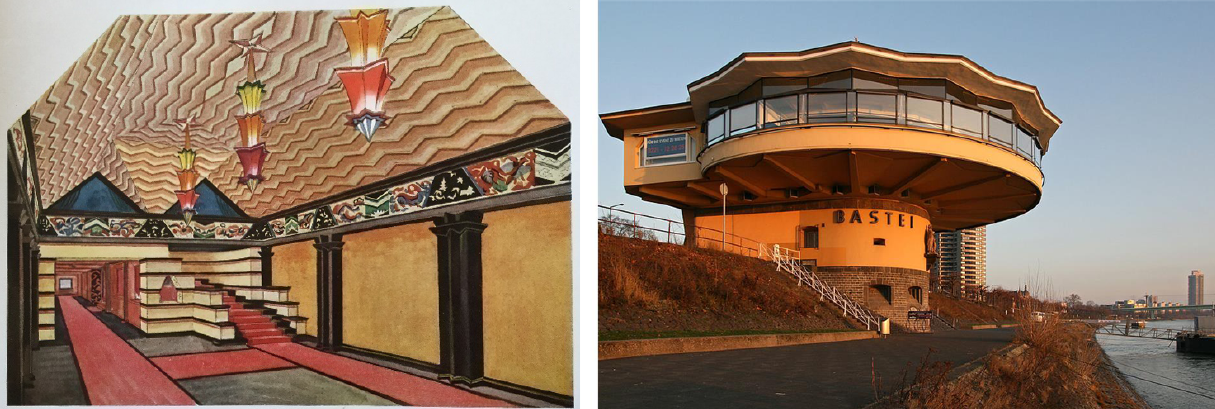
Figure 1. From left to right: W. Riphahn and H. Hansen, Entrance hall and corridor of the Varieté Cavalu theatre, Cologne, 1922 (Hoffmann, 1927); W. Riphahn, Bastion on the banks of the Cologne Rhine, Panorama restaurant on for- mer Kaponniere/Rheinbastion (Superbass, 2008).